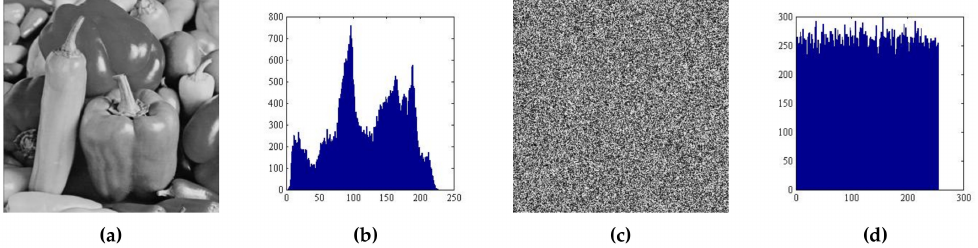
Figure 10. Result of Pepper image. ( a ) Pepper image, ( b ) histogram of Pepper image, ( c ) encrypted Pepper, and ( d ) histogram of encrypted Pepper.